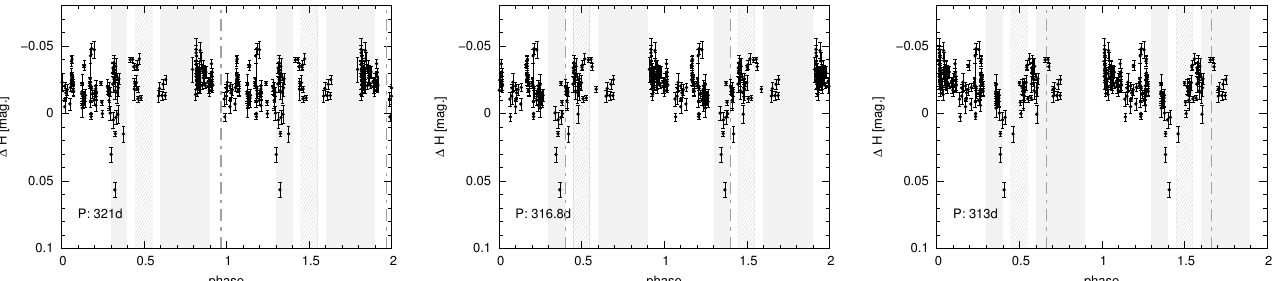
Figure 5. H -band relative magnitude of HESS J0632 + 057 by IRSF/SIRUIS folded with three different orbital periods: 321 days [15] ( left ), 316.8 days [28] ( middle ) and 313 days [17] ( right ). The phases of the X-ray outbursts ( φ ∼ 0.3–0.4 and ∼ 0.6–0.9) are marked with the light-gray shaded area, and that of the dip ( φ ∼ 0.45–0.55) with the striped area. The vertical dash-dotted line in each figure indicates the periastron phase offered by the same reference of the folding period.